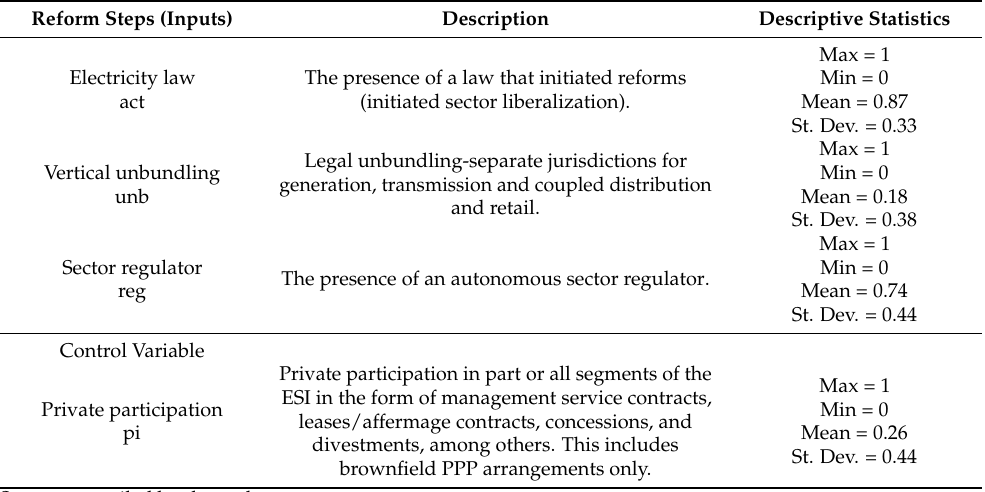
Table 1. Description of reform steps (inputs) and private participation (control